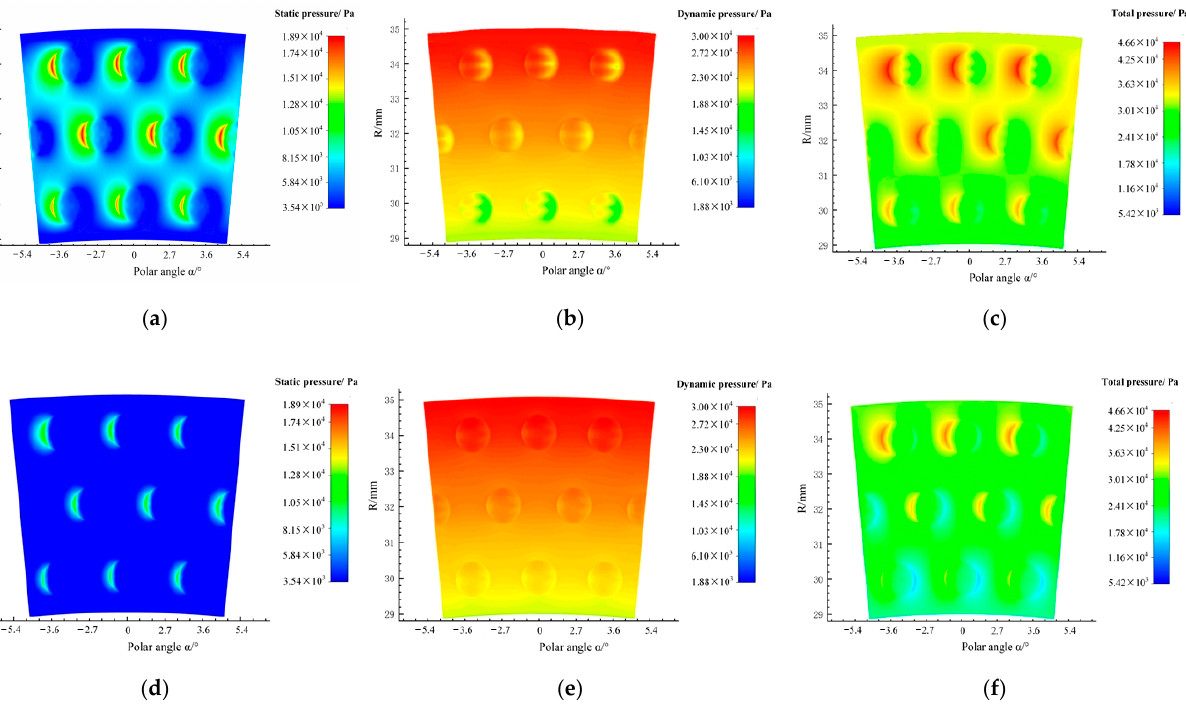
Figure 7. Pressure contours of the upper surface of water film with and without cavitation effect. ( a ) Contour of static pressure introducing cavitation effect; ( b ) Contour of dynamic pressure introducing cavitation effect; ( c ) Contour of total pressure introducing cavitation effect; ( d ) Contour of static pressure without cavitation effect; ( e ) Contour of dynamic pressure without cavitation effect; ( f ) Contour of total pressure without cavitation effect.